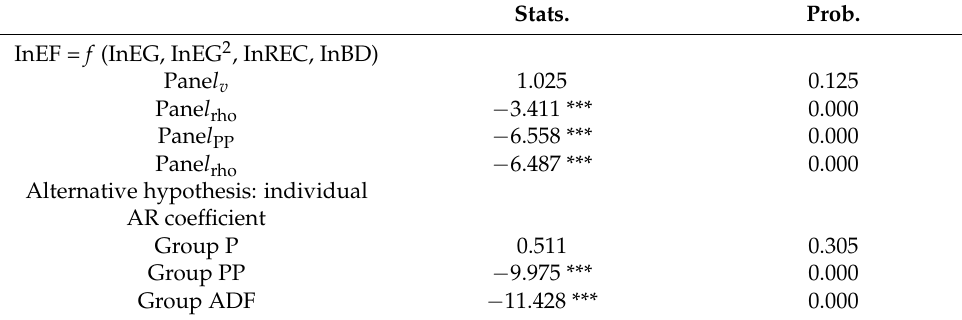
Table 5. The findings of the Pedroni cointegration test.